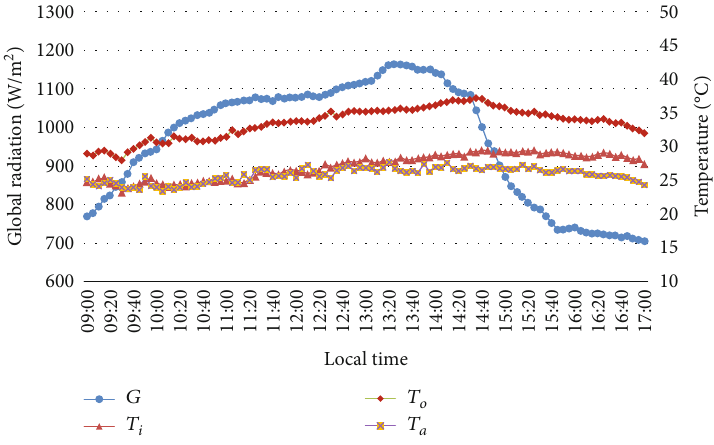
Figure 10: Solar radiation and temperature graphs for TiO